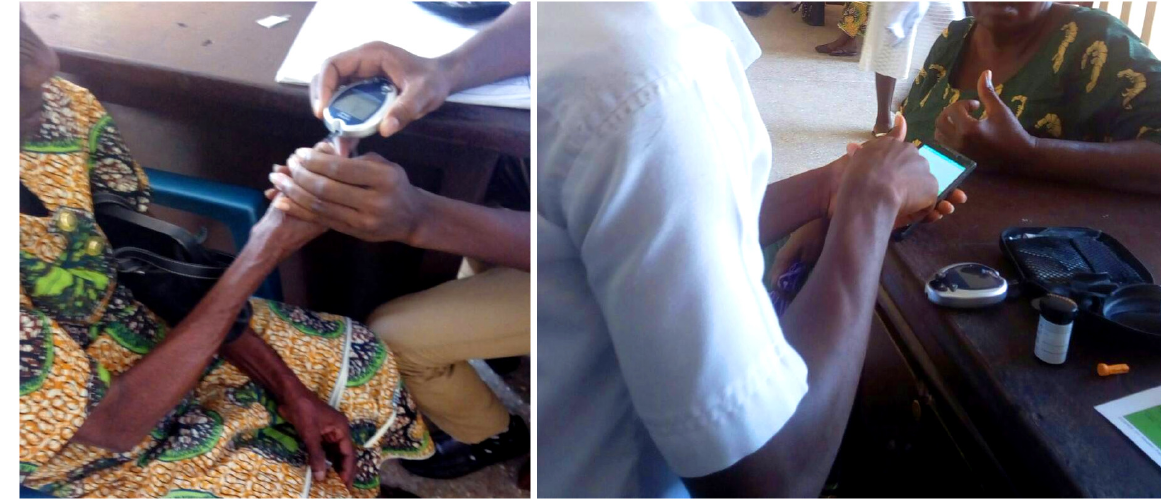
Figure 2. A typical two steps screening, first a nurse is performing a glucose test (on the left), and then the data are recorded through the app (on the